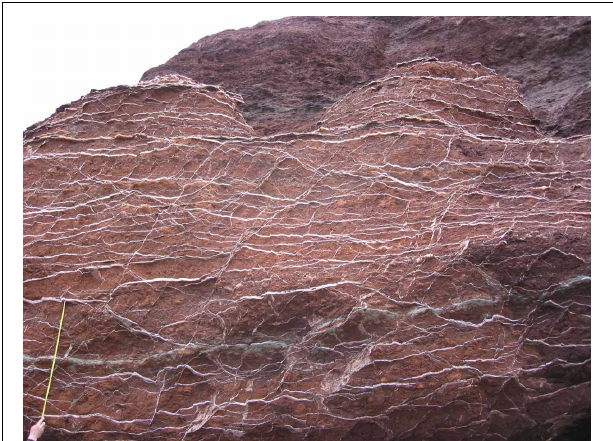
Philipp, 2008), there may develop interconnected networks of mineral veins (here of gypsum) or other hydrofractures. Mudstones commonly have a very low permeability, but such well-interconnected networks of hydrofractures may generate a high temporary permeability. View east; the measuring steel tape is 1m long.